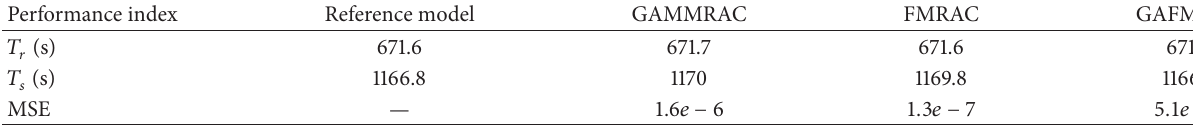
Table 3: Comparison of step responses of different controllers.